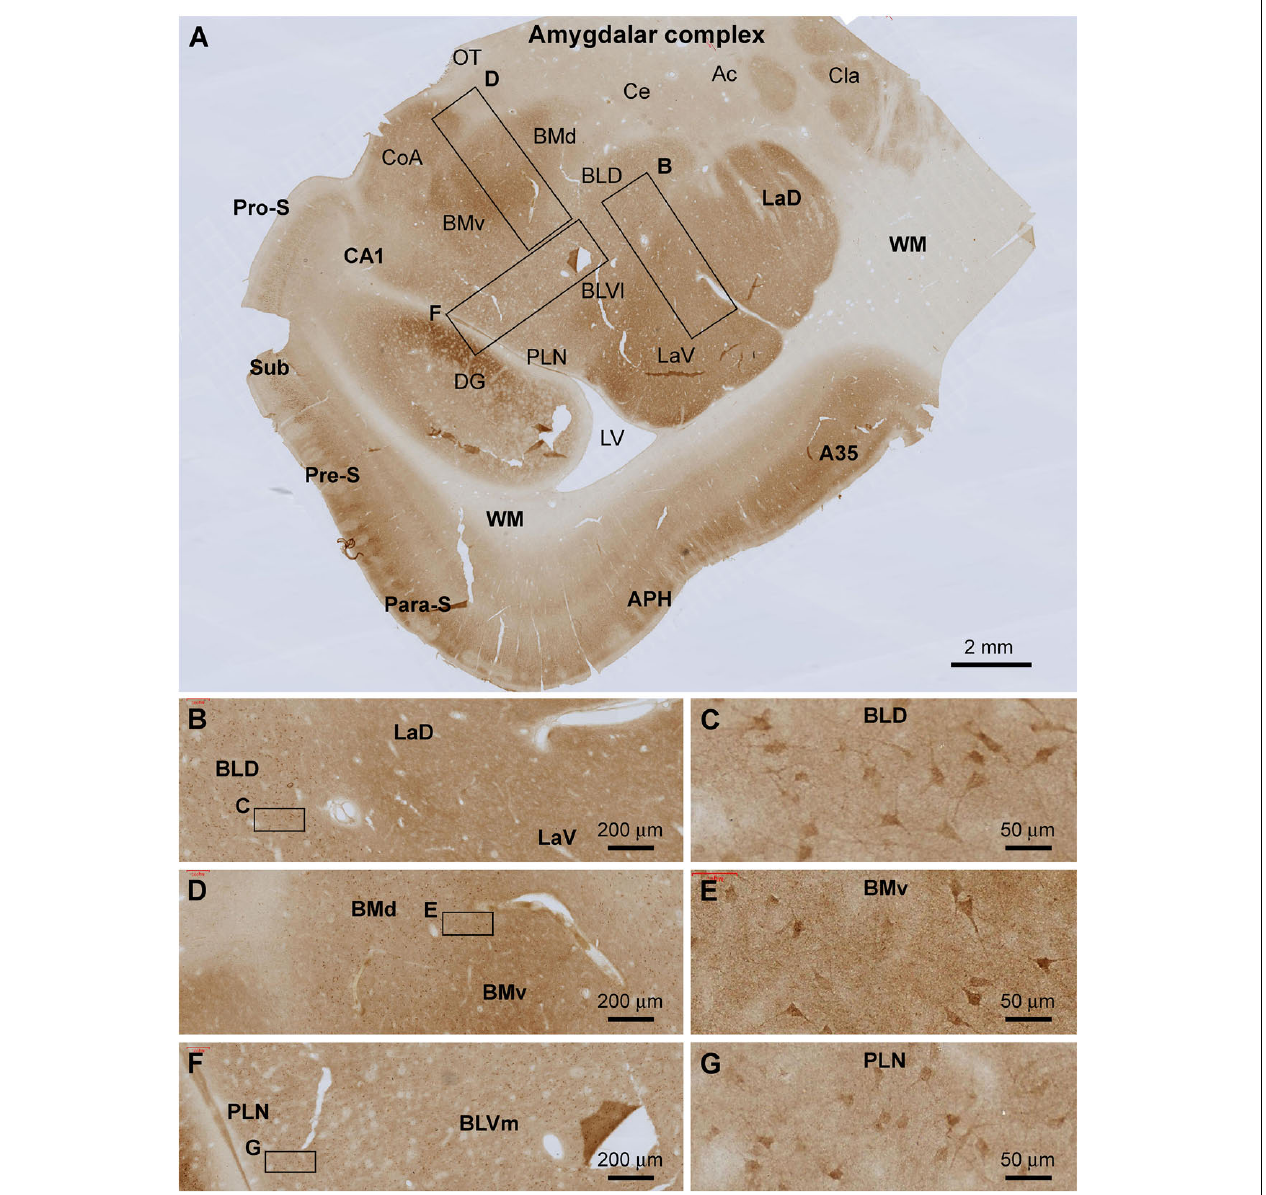
FIGURE 4 | Localization of Shank3 IR in the amygdalar complex. Panel (A) is a low magnification image of temporal lobe section at the level between the amygdala and hippocampus, with framed areas enlarged as (B–G) . Shank3 IR occurs in all amygdalar subregions with variable labeling intensity. Thus, stronger IR is present in the lateral nuclei group, including both the dorsal and ventral subdivisions (LaD, LaV), and the basomedial group including the dorsal and ventral subdivisions (BMd, BMv). At high magnifications, the IR exhibits a spreading neuropil pattern but also occurs in relatively large-sized perikarya in multipolar shape, including the